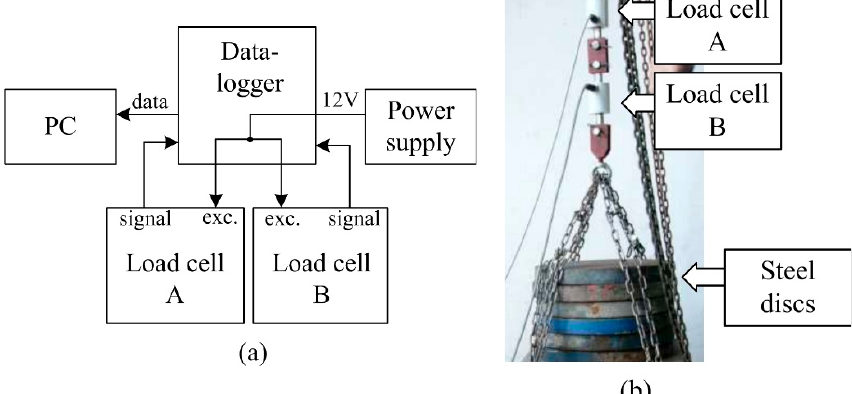
Figure 6. Measurement system: ( a ) Scheme of the system; ( b ) Calibration test using the predicted load.